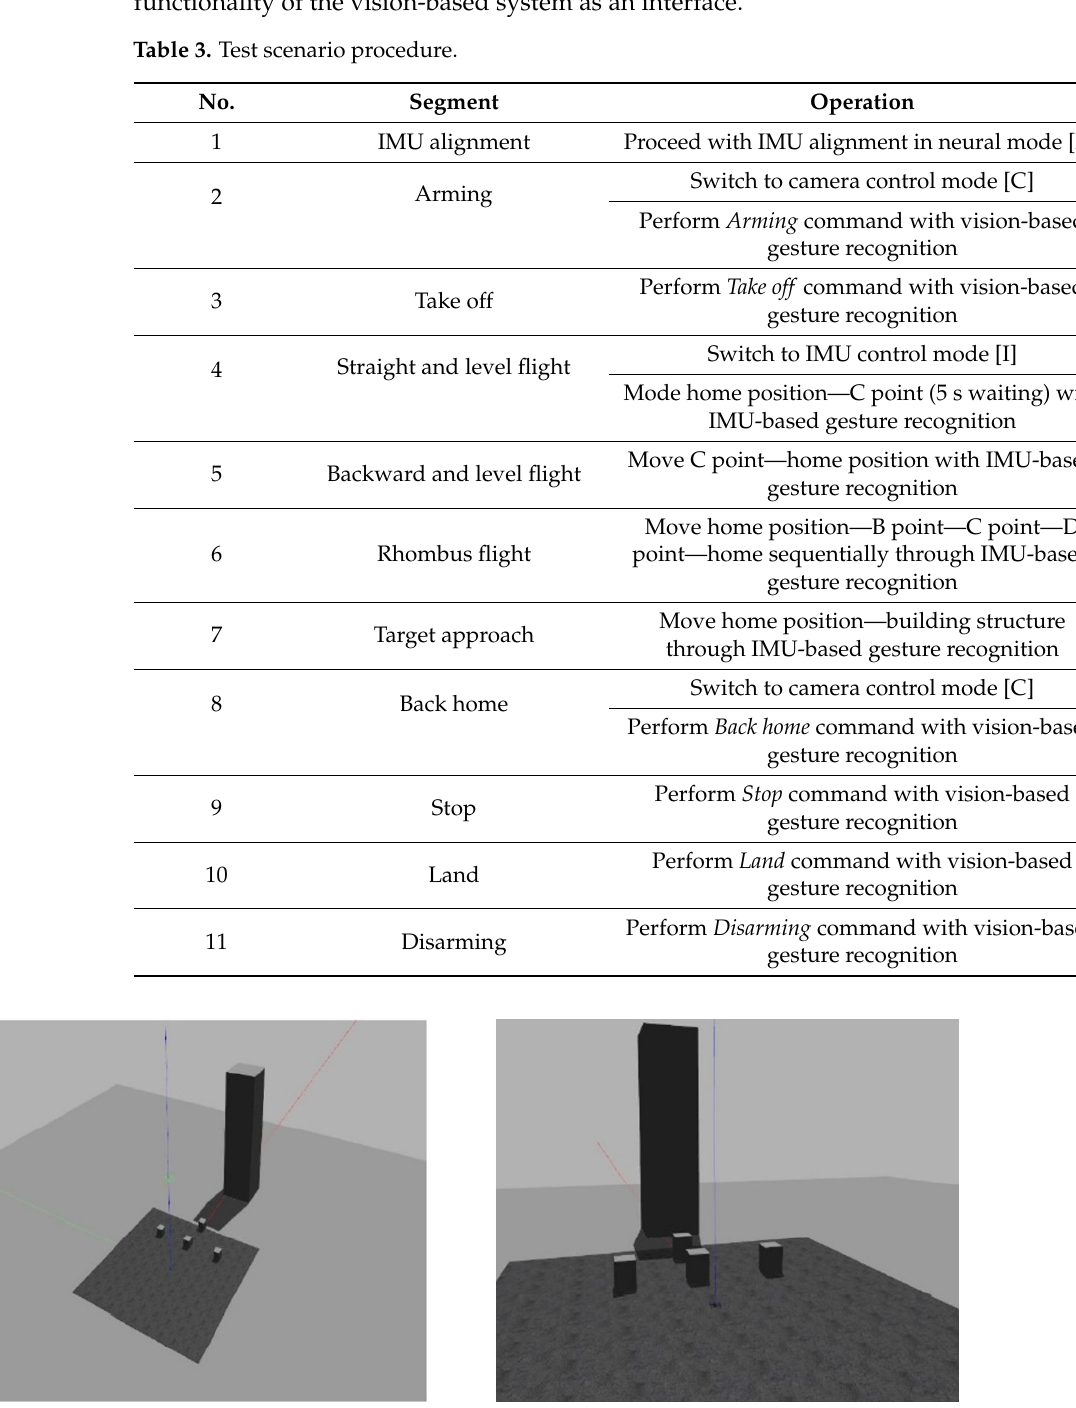
Figure 11. Implementation of simulation environment using the Gazebo.